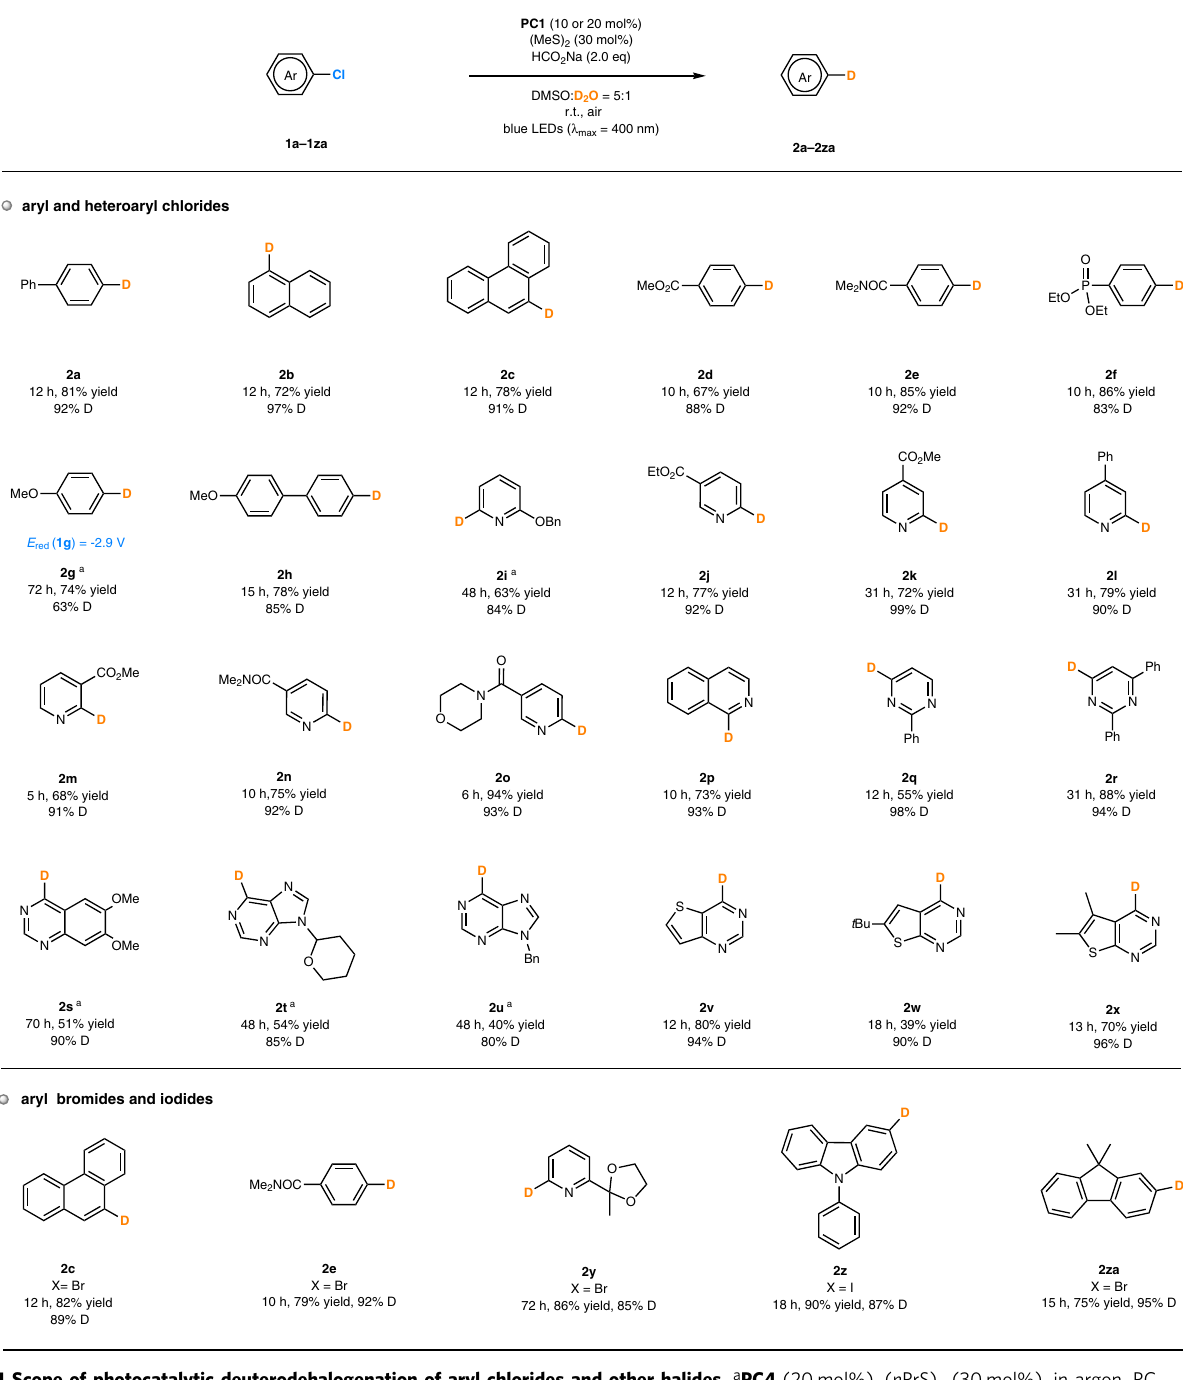
Fig. 4 Scope of photocatalytic deuterodehalogenation of aryl chlorides and other halides. a PC4 (20 mol%), ( n PrS) 2 (30 mol%), in argon. PC, photocatalyst; r.t., room temperature; eq, equivalent; DMSO, dimethyl